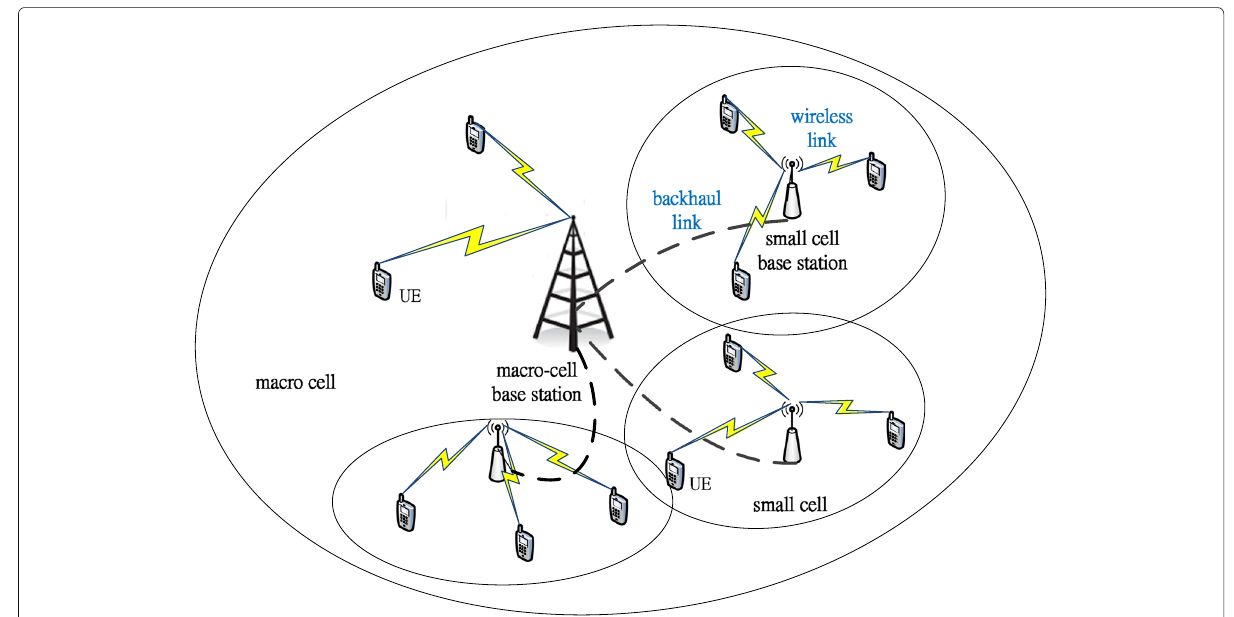
Fig. 1 An example of the heterogeneous